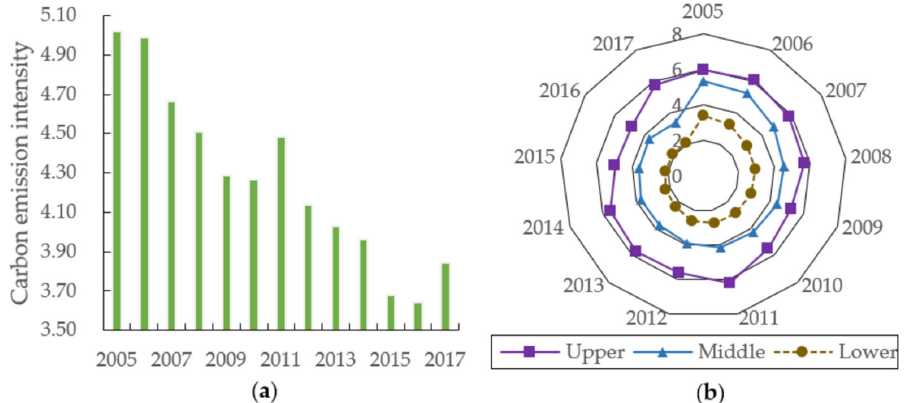
Figure 2. Spatial and temporal evolution of carbon emission intensity in the YRB. ( a ) Average value of carbon emission intensity in the YRB; ( b ) Carbon emission intensity of three regions.